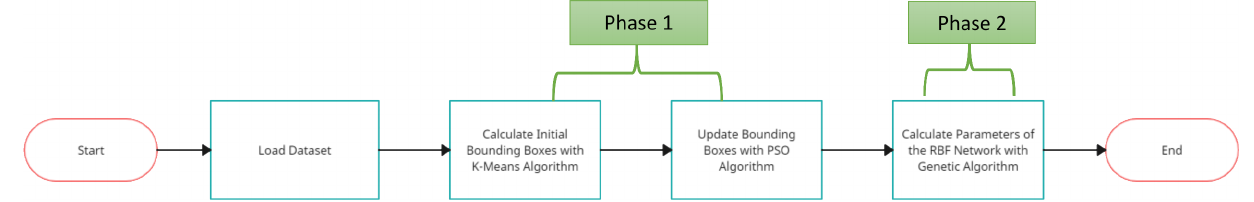
Figure 3. Graphical representation of the proposed two-phase